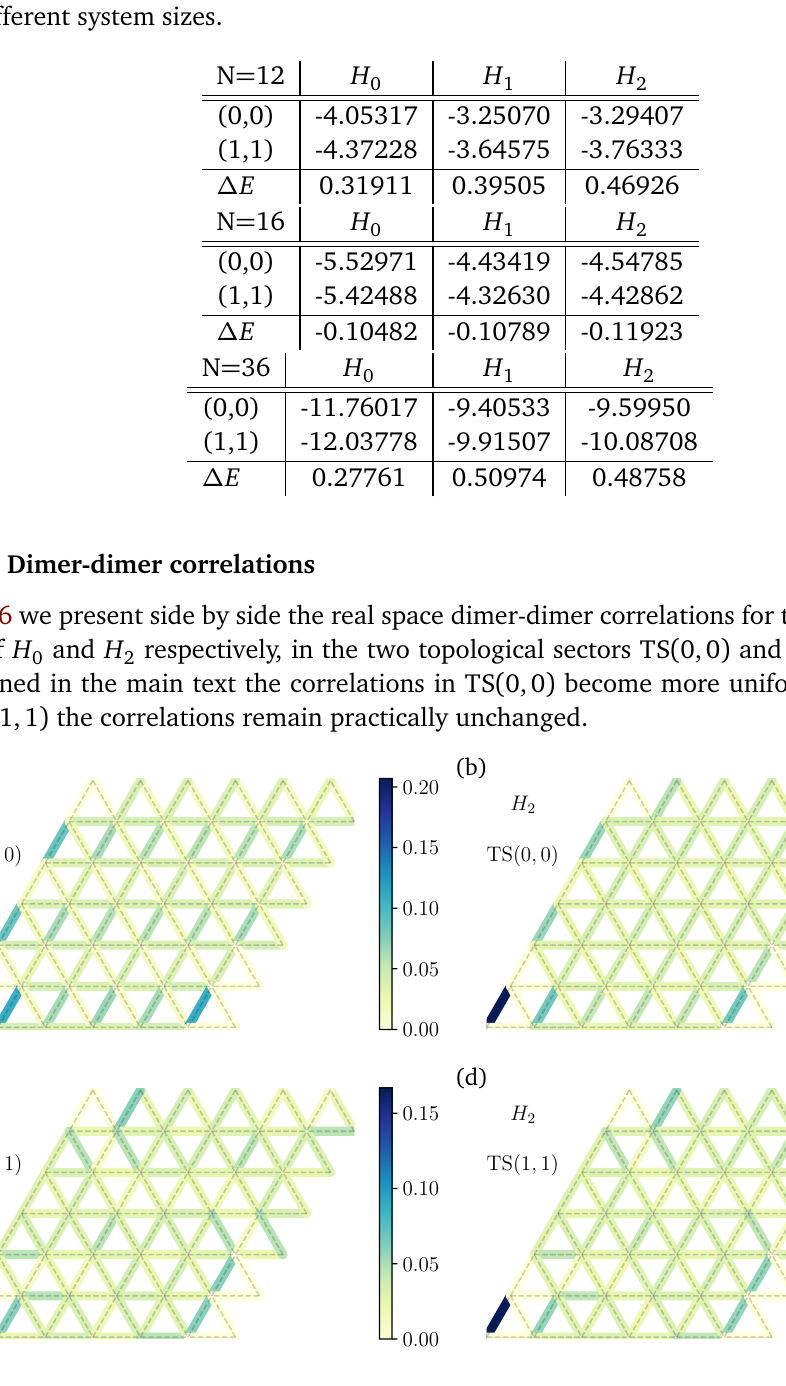
〉 , in the lowest energy state in the b Figure 6: Dimer-dimer correlations 〈 b i 1 topological sectors TS ( 0,0 ) and TS ( 1,1 ) respectively for the standard dimer model with v / t = 0, H , on the left, and of the extended dimer model H 0